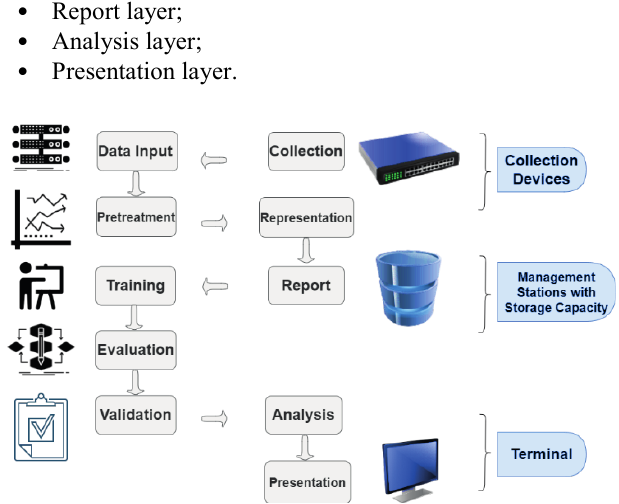
Fig. 3. Sub-classification of monitoring operations with learning and prediction, projection of the machine learning system on the monitoring layer.